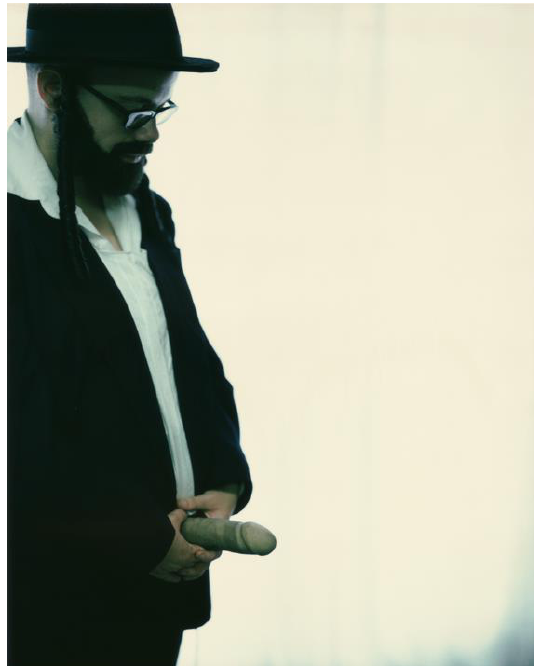
Figure 5. Oreet Ashery, Self Portrait as Marcus Fisher III , 2000, original 25.4 × 20 cm; Polaroid scanned to lambda prints, 100 × 110 cm. Photograph by Manuel Vason. Courtesy of the artist.